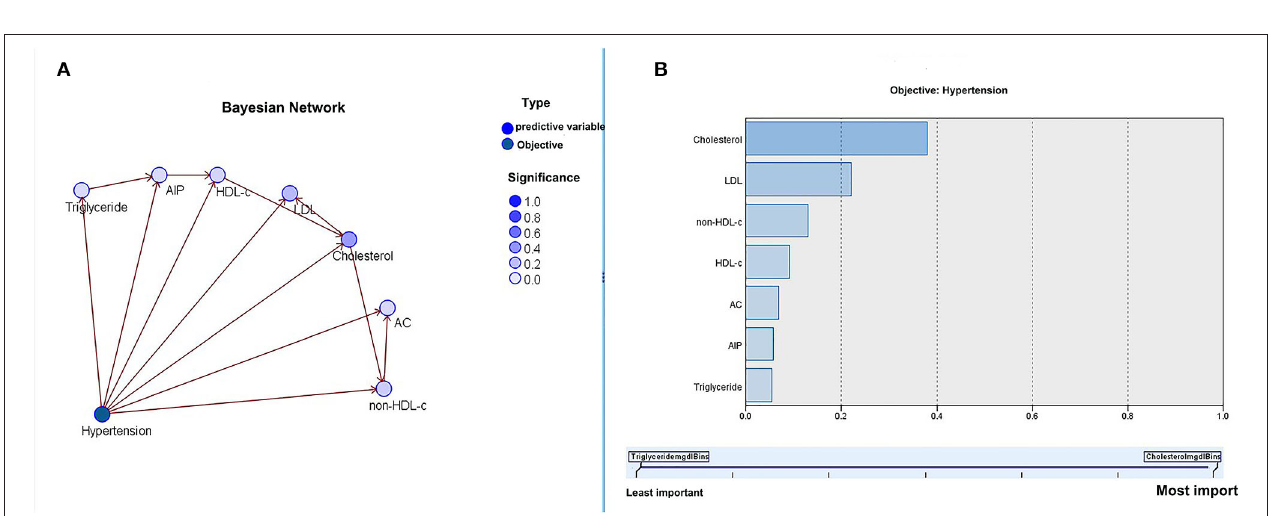
FIGURE 4 | The Bayesian model based on the TAN algorithm: the relationship between baseline characteristics and the incidence of hypertension (A) and the importance of predictors (B) .